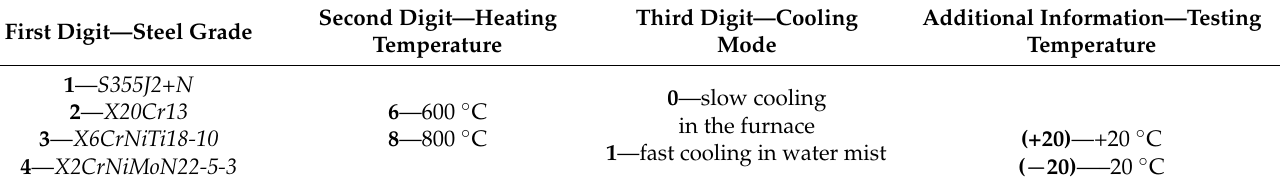
Table 1. Description mode of the samples subjected to impact strength